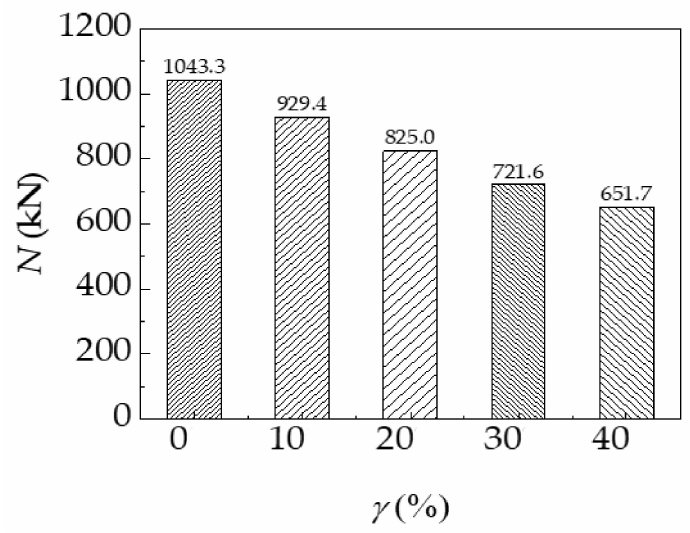
Figure 8. The ultimate bearing capacity of the specimen under different corrosion